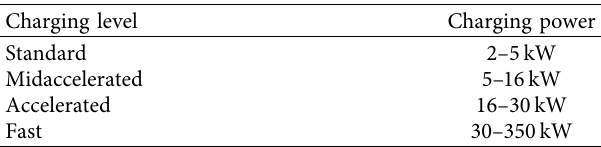
Figure 1: Energy consumption function of the EV. Table 2: The current charging levels of the charging stations in the market.